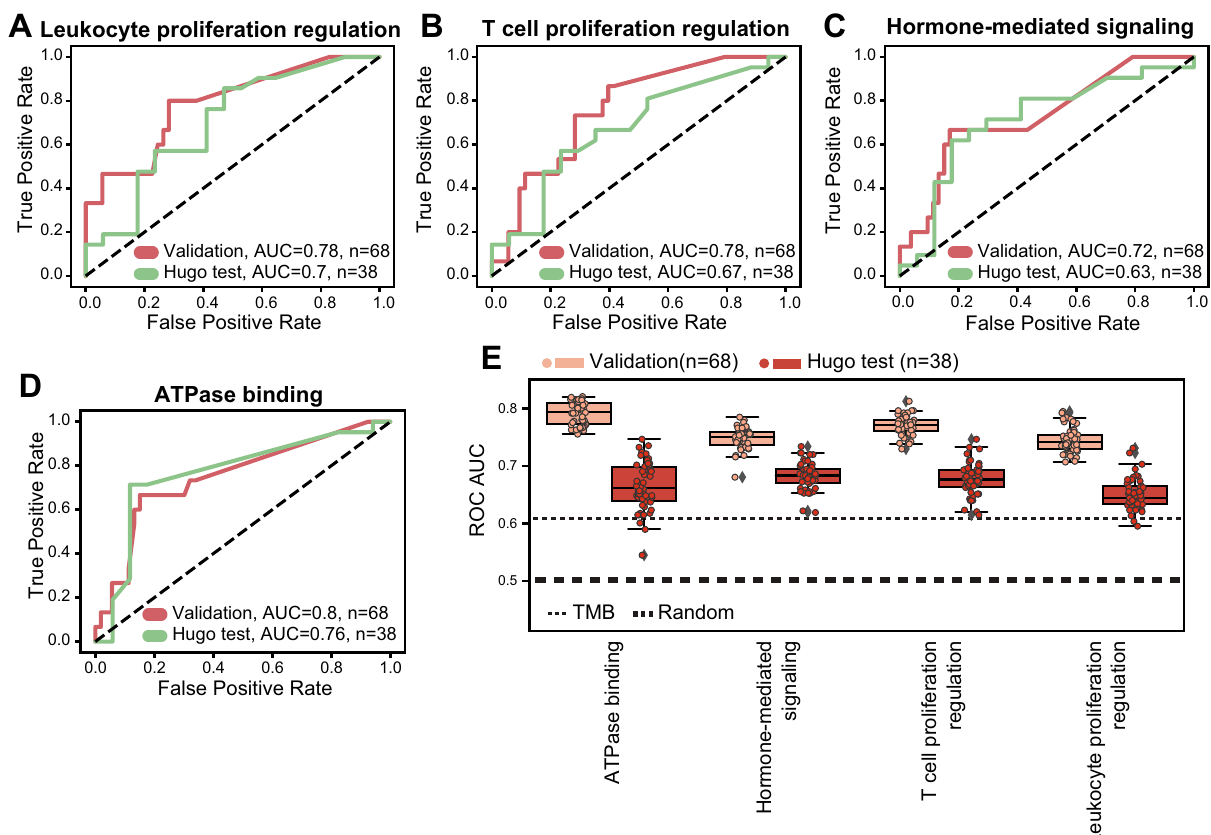
Fig. 2 | Evaluation of the RF processes classi fi ers. A – D ROC curves showing the performances of the RF models for the validation and Hugo test datasets, when trained using mutations within the leukocyte-proliferation regulation process ( A ), the T-cell proliferation regulation process ( B ), the hormone-mediated signaling process ( C ), and the ATPase binding process ( D ). E Robustness analysis evaluating the validation performances of the RF process models when retrained with